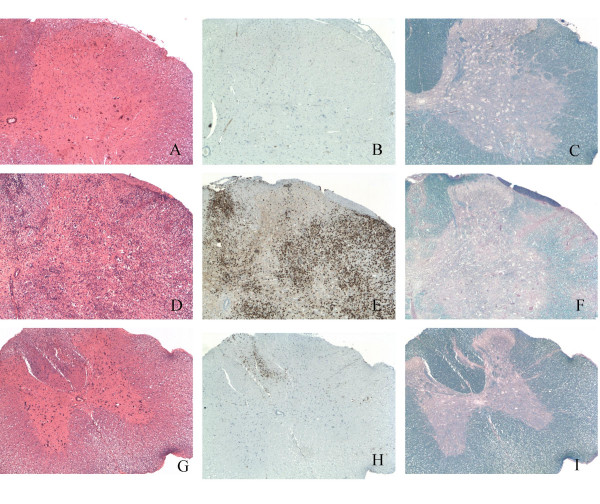
Histopathological features of MOG-EAE during the acute and remission stages. Spinal cord sections from a rat in the acute stage (day 13 post immunization) of EAE show extensive inflammation involving the white and grey matter (D), with marked demyelination in the inflammatory areas (F). The majority of the infiltrating inflammatory cells are macrophages, as evidenced by positive staining for the ED-1 marker (E). During the remission phase (day 18 post immunization), inflammation (G) and infiltration of macrophages (H), as well as demyelination (I) are substantially reduced. A normal control rat is included for comparison (A, B, C). H&E staining (A, D, G), ED-1 immunohistochemistry (B, E, H), LFB/PAS staining (C, F, I). Magnification: lens × 4.